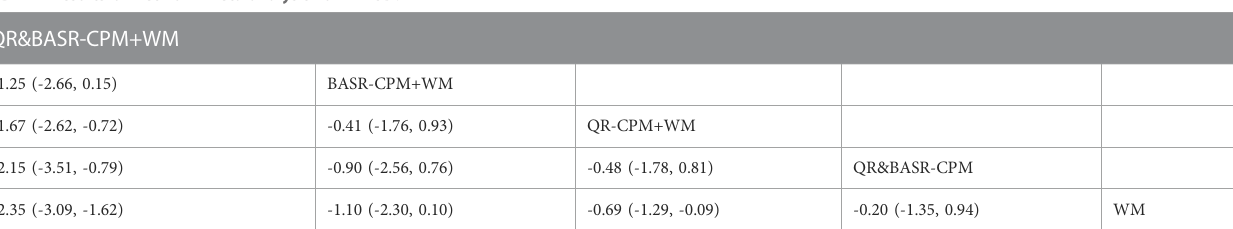
TABLE 7 Results of network meta-analysis for LVESD.